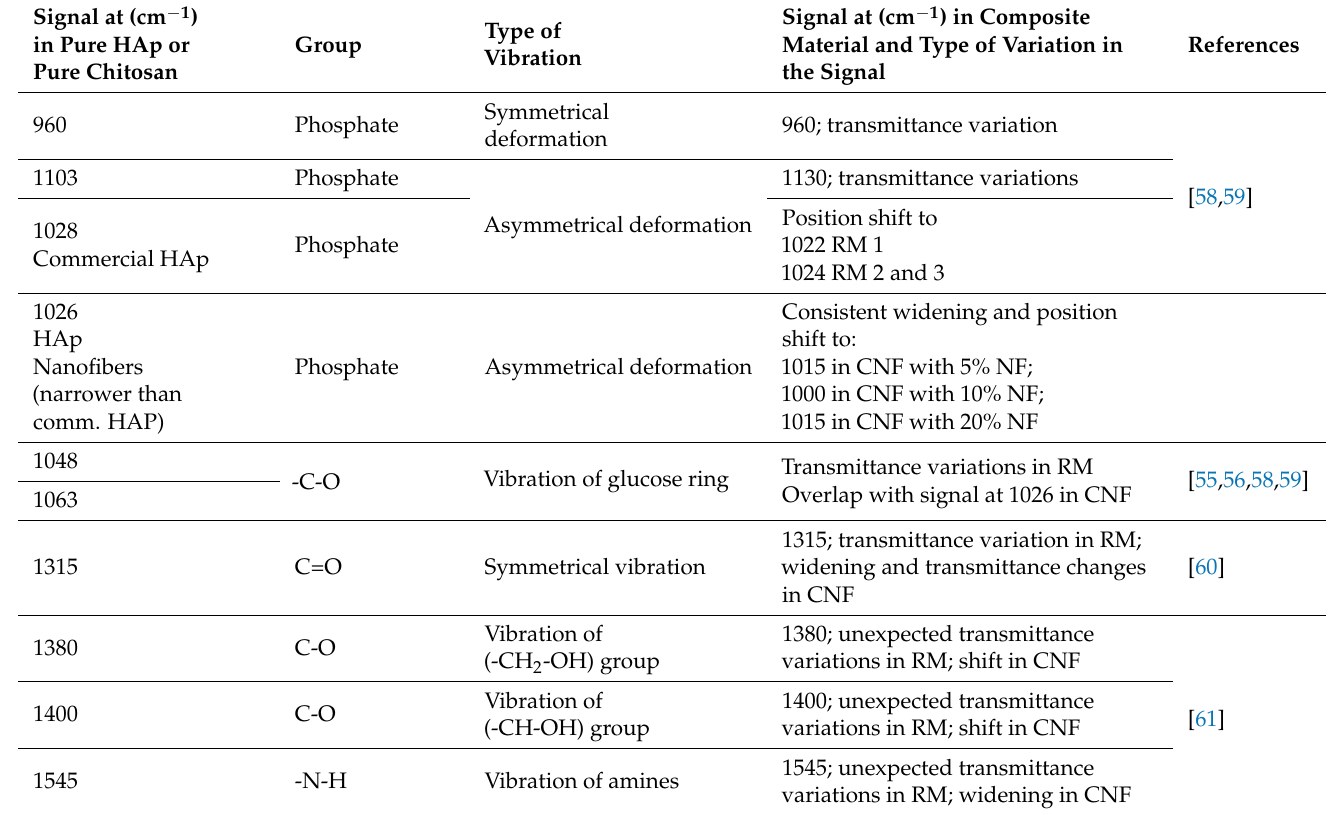
Table 1. Positions of and variations in FTIR signals from all types of